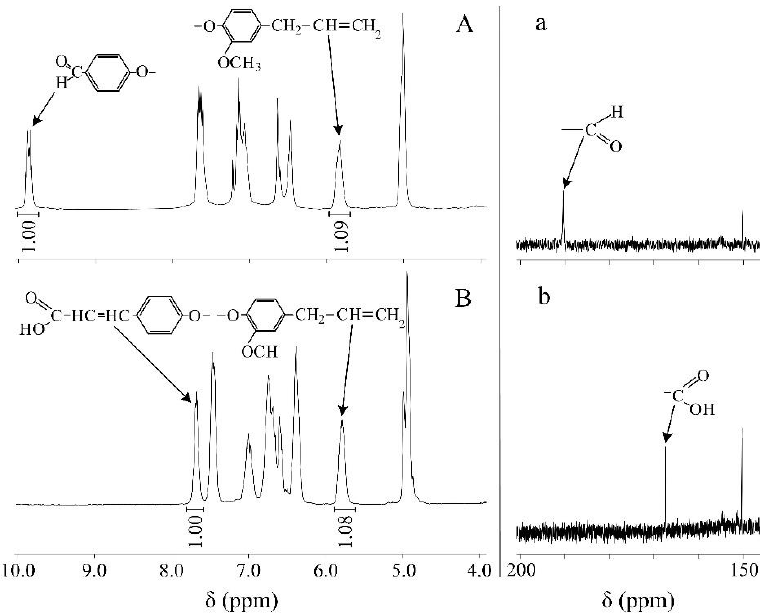
Figure 3. 1 H NMR ( A and B ) and 13 C NMR ( a and b ) of compounds II and III,